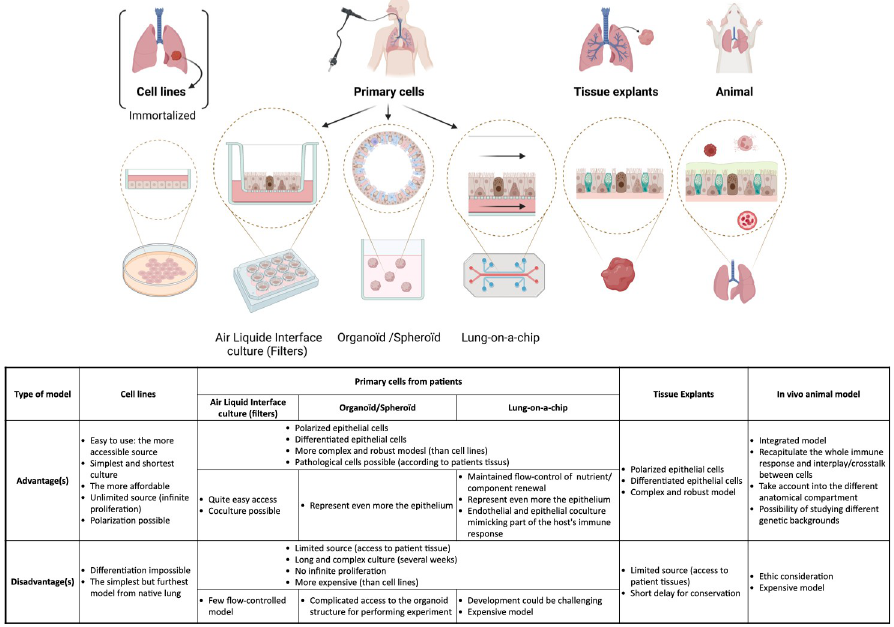
Fig 5. Models of airway epithelia. It is of the utmost importance to use relevant experimental models to assess the host–pathogen interactions driving P . aeruginosa infection, depending on the physiological relevance needed: Various models exist, from cell lines to primary cells and tissue explants/animal models, each with their advantages and disadvantages. All the models used in the references of the review are listed in S1 Table. Created with